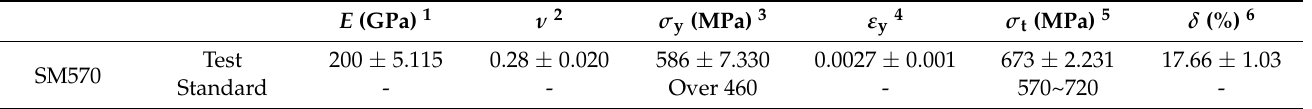
Figure 2. Engineering stress-engineering strain curves of base metal specimen. Table 1. Mechanical properties of SM570.